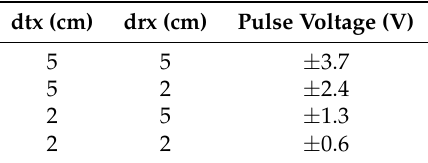
Table 3. Sensing amplifier pulse